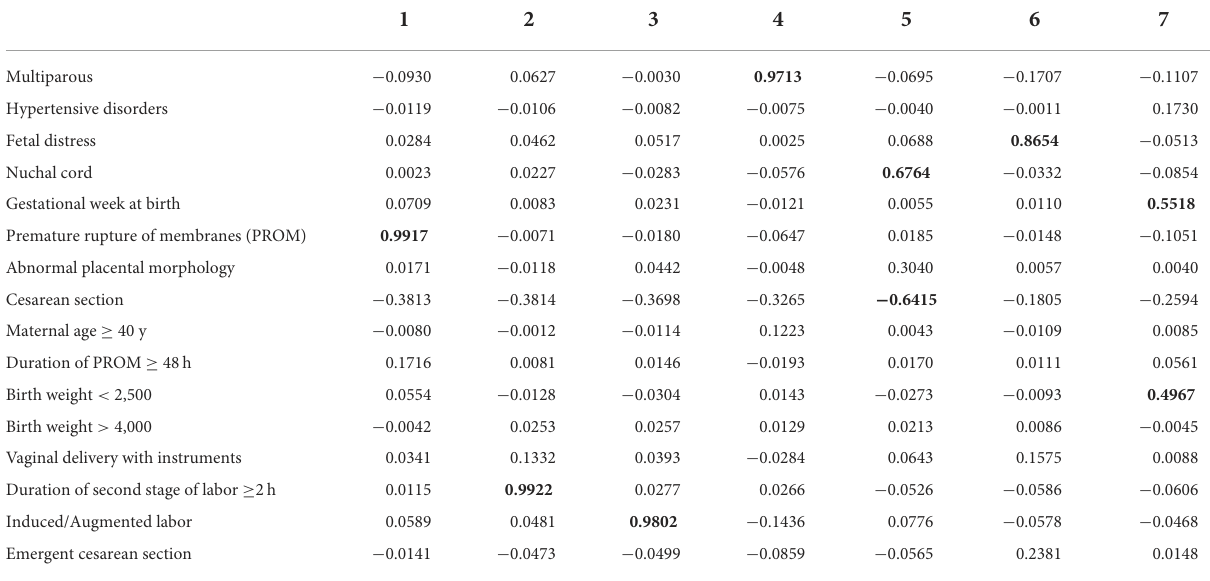
TABLE 3 Matrix of load of factors.